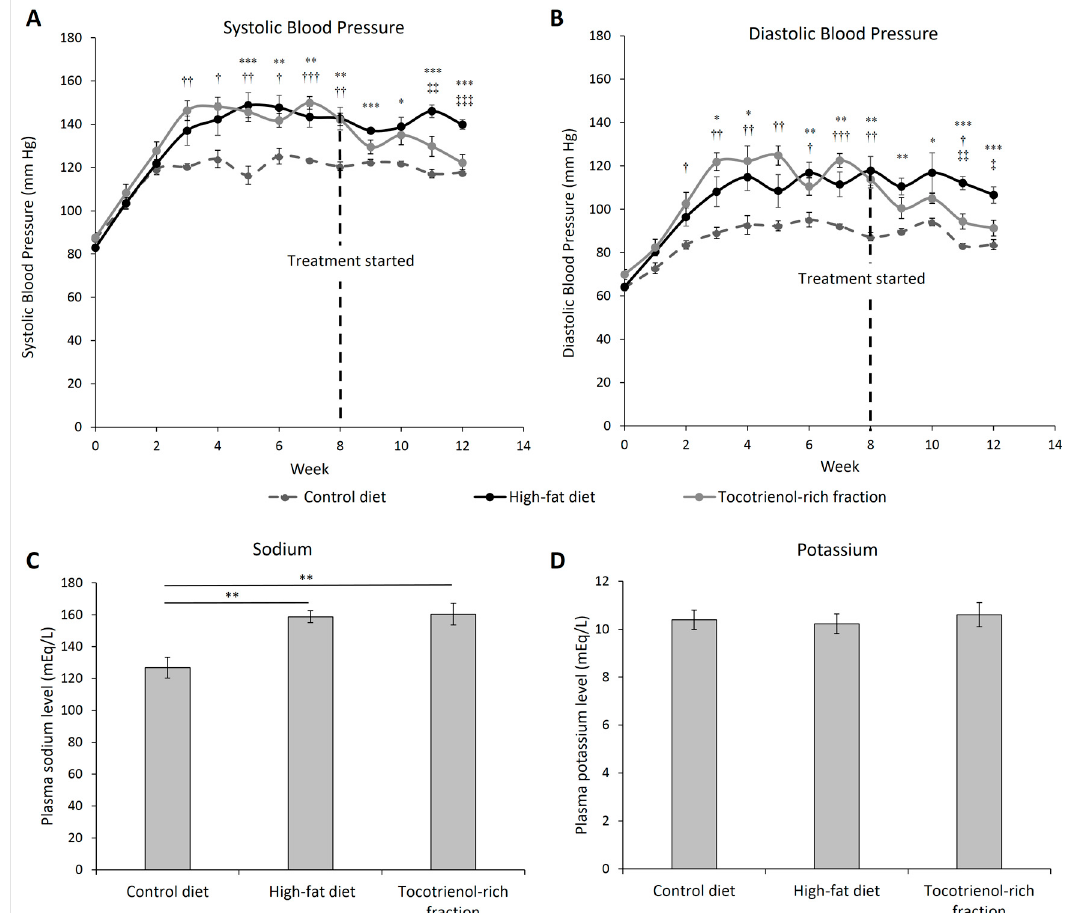
Figure 3. Systolic ( A ) and diastolic ( B ) blood pressure of the rats assigned to different treatment groups throughout 12 weeks. A tocotrienol-rich fraction was administered after 8 weeks of high-fat feeding as indicated by the black dotted line. Plasma sodium ( C ) and potassium ( D ) levels at the end of treatment was measured. Error bars indicate SEM. The sample size was n = 7 per group. For Figure 3A,B, *, **, *** indicate p < 0.05, 0.01, 0.001 between and control and high-fat diet groups; †, ††, ††† indicate p < 0.05, 0.01, 0.001 between the control diet and tocotrienol-rich fraction groups; ‡, ‡‡, ‡‡‡ indicate p < 0.05, 0.01, 0.001 between the high-fat diet and tocotrienol-rich fraction groups . For Figure 3C,D, ** indicates p < 0.01 between groups.